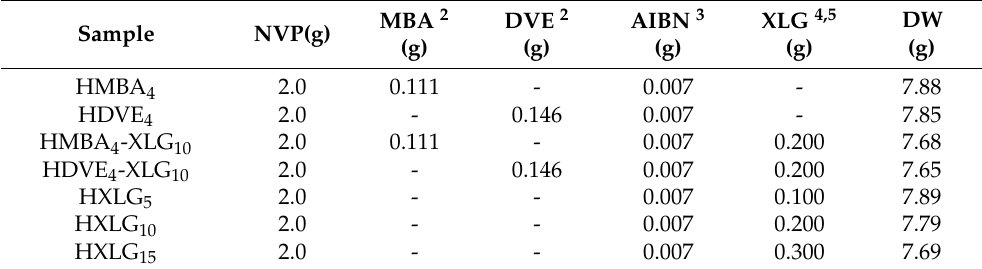
Table 1. The composition of the hydrogel preparation mixtures 1